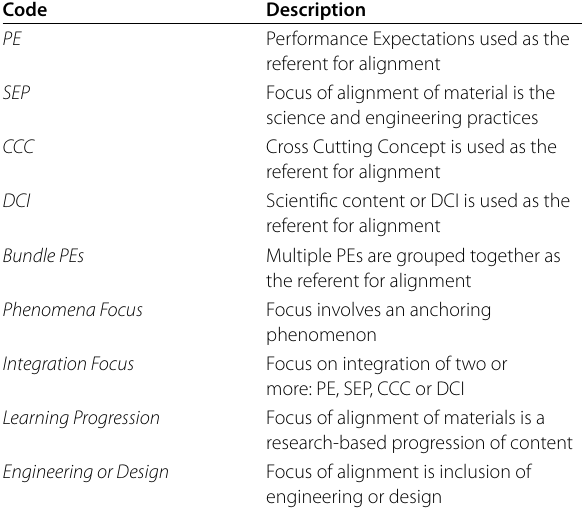
Table 2 A priori Alignment Codes from Literature Review ( Fulmer et al.,